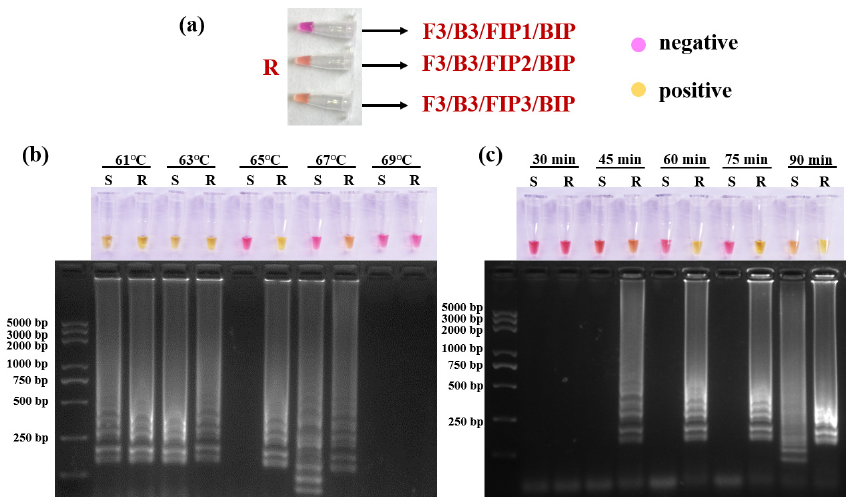
Figure 4. Optimization of LAMP reaction conditions for G143A in Corynespora cassiicola . ( a ) Selection of FIP primer of LAMP reaction. Optimization of the LAMP reaction temperature ( b ) and time ( c ) on the basis of color change (upper) and corresponding gel electrophoresis detection (lower). Reaction temperature gradient was set to 61, 63, 65, 67, and 69 °C, and the reaction time gradient was 30, 45, 60, 75, and 90 min. “S”, pyraclostrobin-sensitive isolate Cc4; “R”, pyraclostrobin-resistant isolate Cc66. Horticulturae 2021 , 7 , x The lowest detection limit of the LAMP reaction was determined using the primer set (F3, B3, FIP3, and BIP) and tenfold serial dilutions of genomic DNA containing the G143A mutation from 100 ng/ μ L. The detection limit of LAMP is 0.01 ng/ μ L, and the de- tection limit of conventional PCR is 1 ng/ μ L (Figure 5).